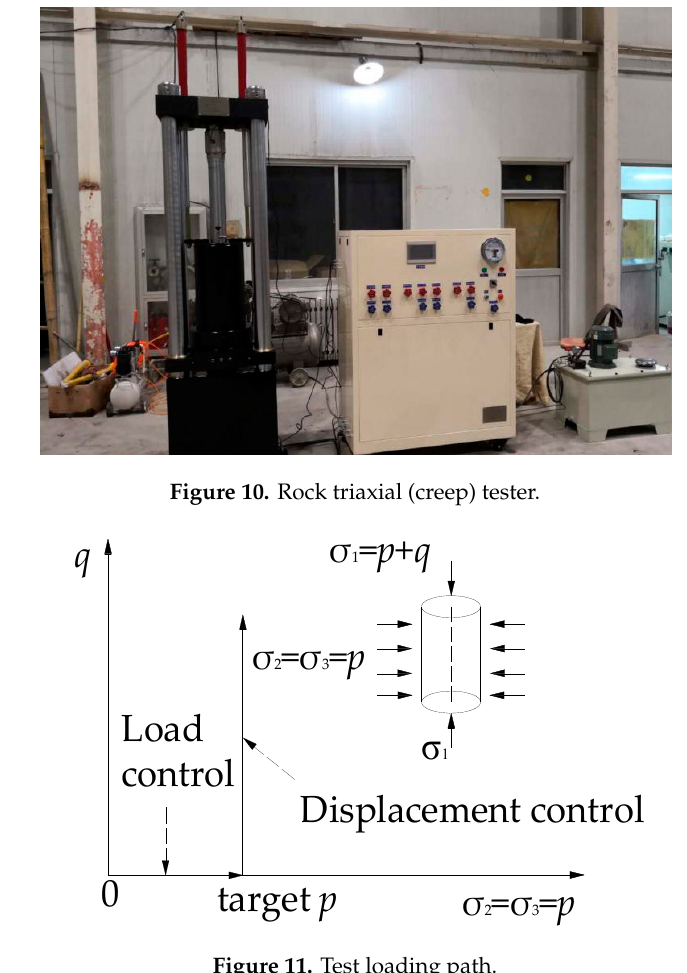
Figure 11. Test loading path.